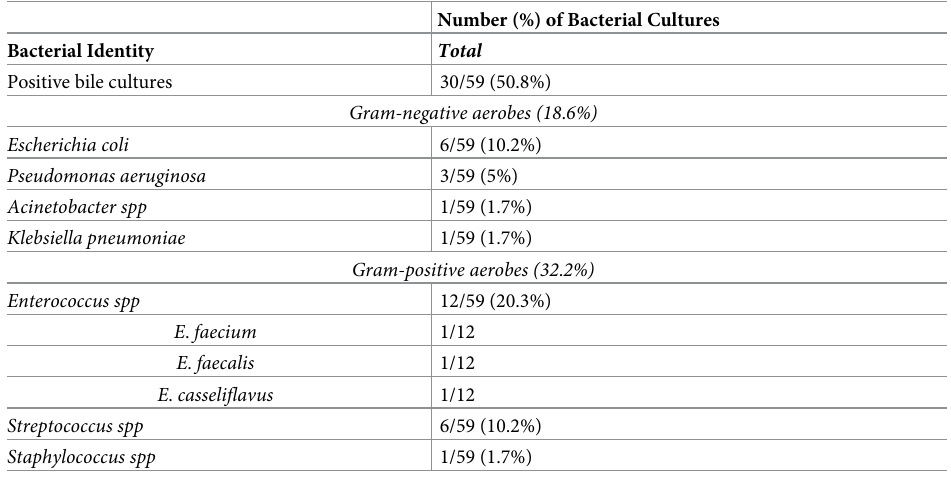
Table 1. Aerobic culture